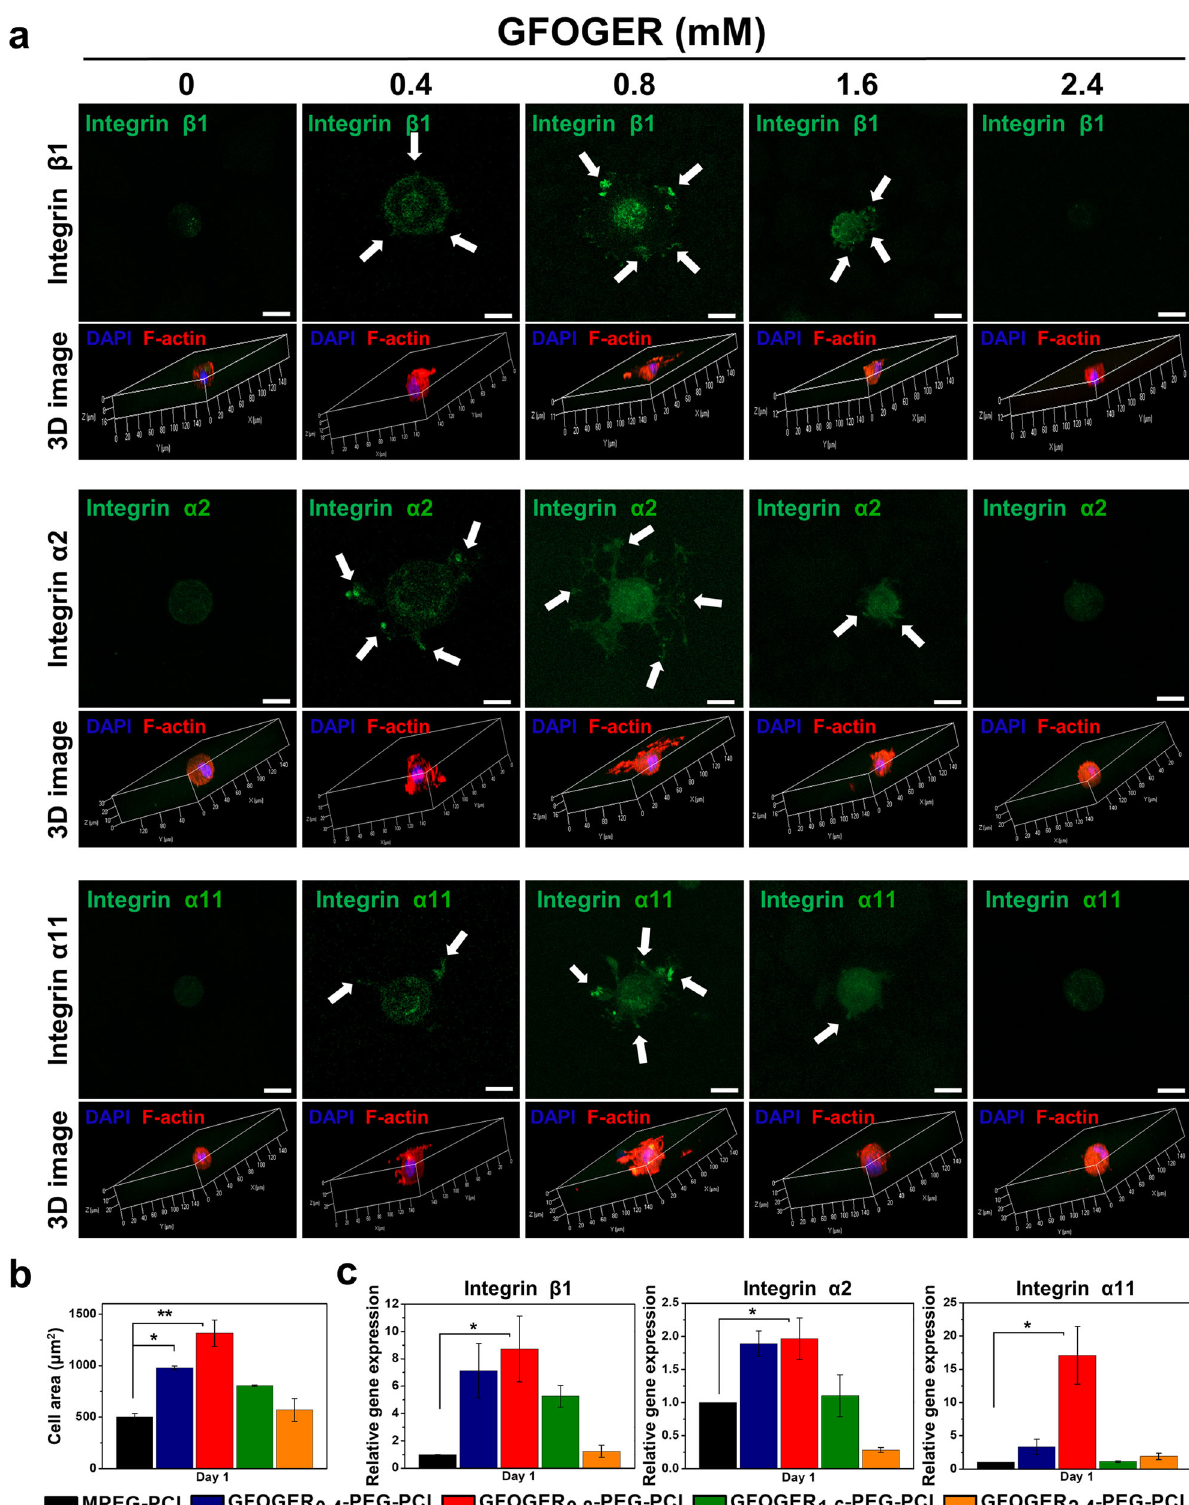
Fig. 3 Evaluation of integrin expression and cell morphology induced by hydrogel formulations at day 1. a Immuno fl uorescence assay of integrins β 1, α 2, and α 11 expressions (green, white arrows), F-actin (red) and nucleus (blue) (scale bar, 5 μ m). And confocal laser scanning microscope 3D images of a cell morphology in hydrogels. b Quanti fi cation of cell spreading area analyzed based on 3D cell images of a cell morphology in hydrogels. c mRNA expressions of integrin β 1, α 2, and α 11 of BMSCs cultured in hydrogels for 1 day (Data in ( b , c ) are shown as mean ± SD, unpaired Student ’ s t -test. * p < 0.05 and ** p <